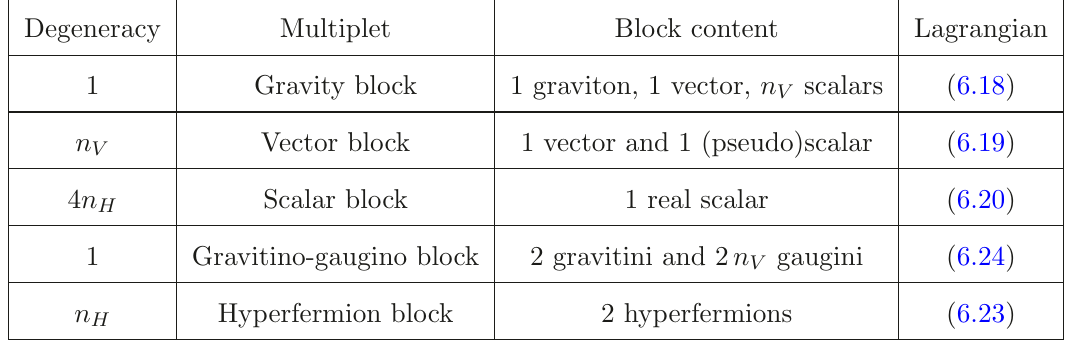
= 2 SUGRA around a general KK black N